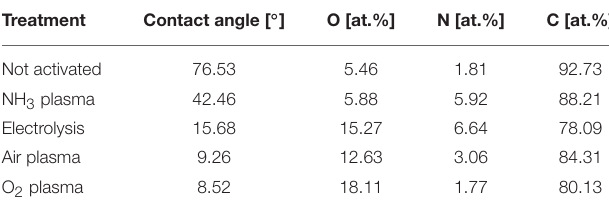
TABLE 4 | Physical characterization of surface activated HTS40